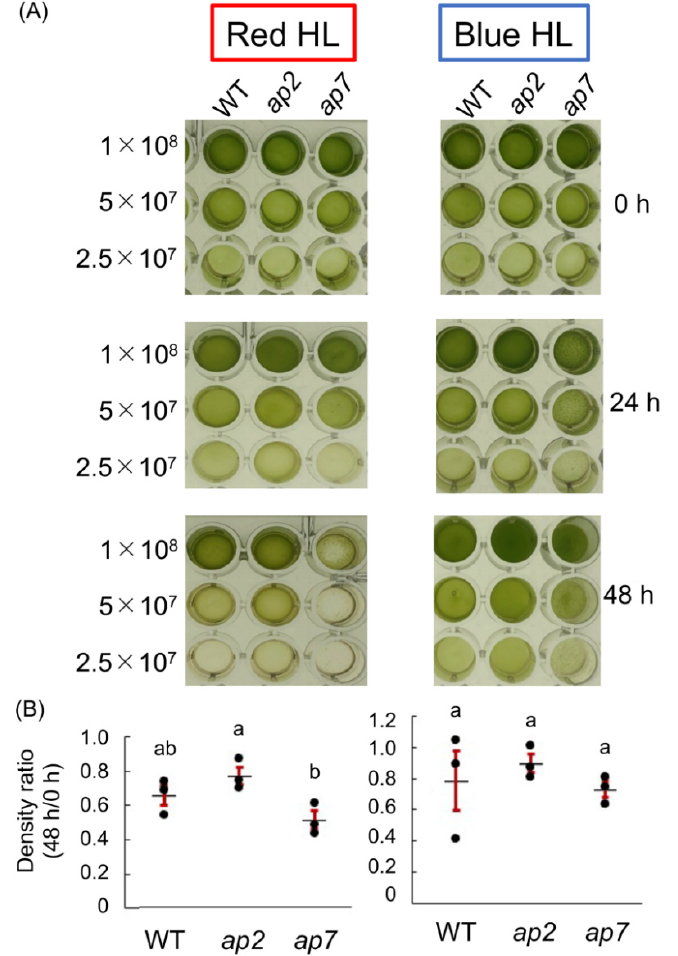
Figure 5. High-light tolerance of ap2 and ap7 under red or high blue light. ( A ) Dilution series of WT, ap2 , and ap7 cell culture (2.5 × 10 7 –1 × 10 8 cells/mL) were illuminated with either red high light (left; λ = 640 nm, 800 µ mol photons m − 2 s − 1 ) or blue high light (right; λ = 470 nm, 300 µ mol photons m − 2 s − 1 ) for two days. ( B ) The density of each well was measured, and the ratio of the value at 48 h per that at 0 h was calculated. Each dot represents the individual result, and mean values (black bars) ± S.E.M. (red bars) (n = 3) are shown. Different letters indicate significant differences ( p < 0.05, one-way ANOVA and Tukey’s honest significance difference (HSD)).